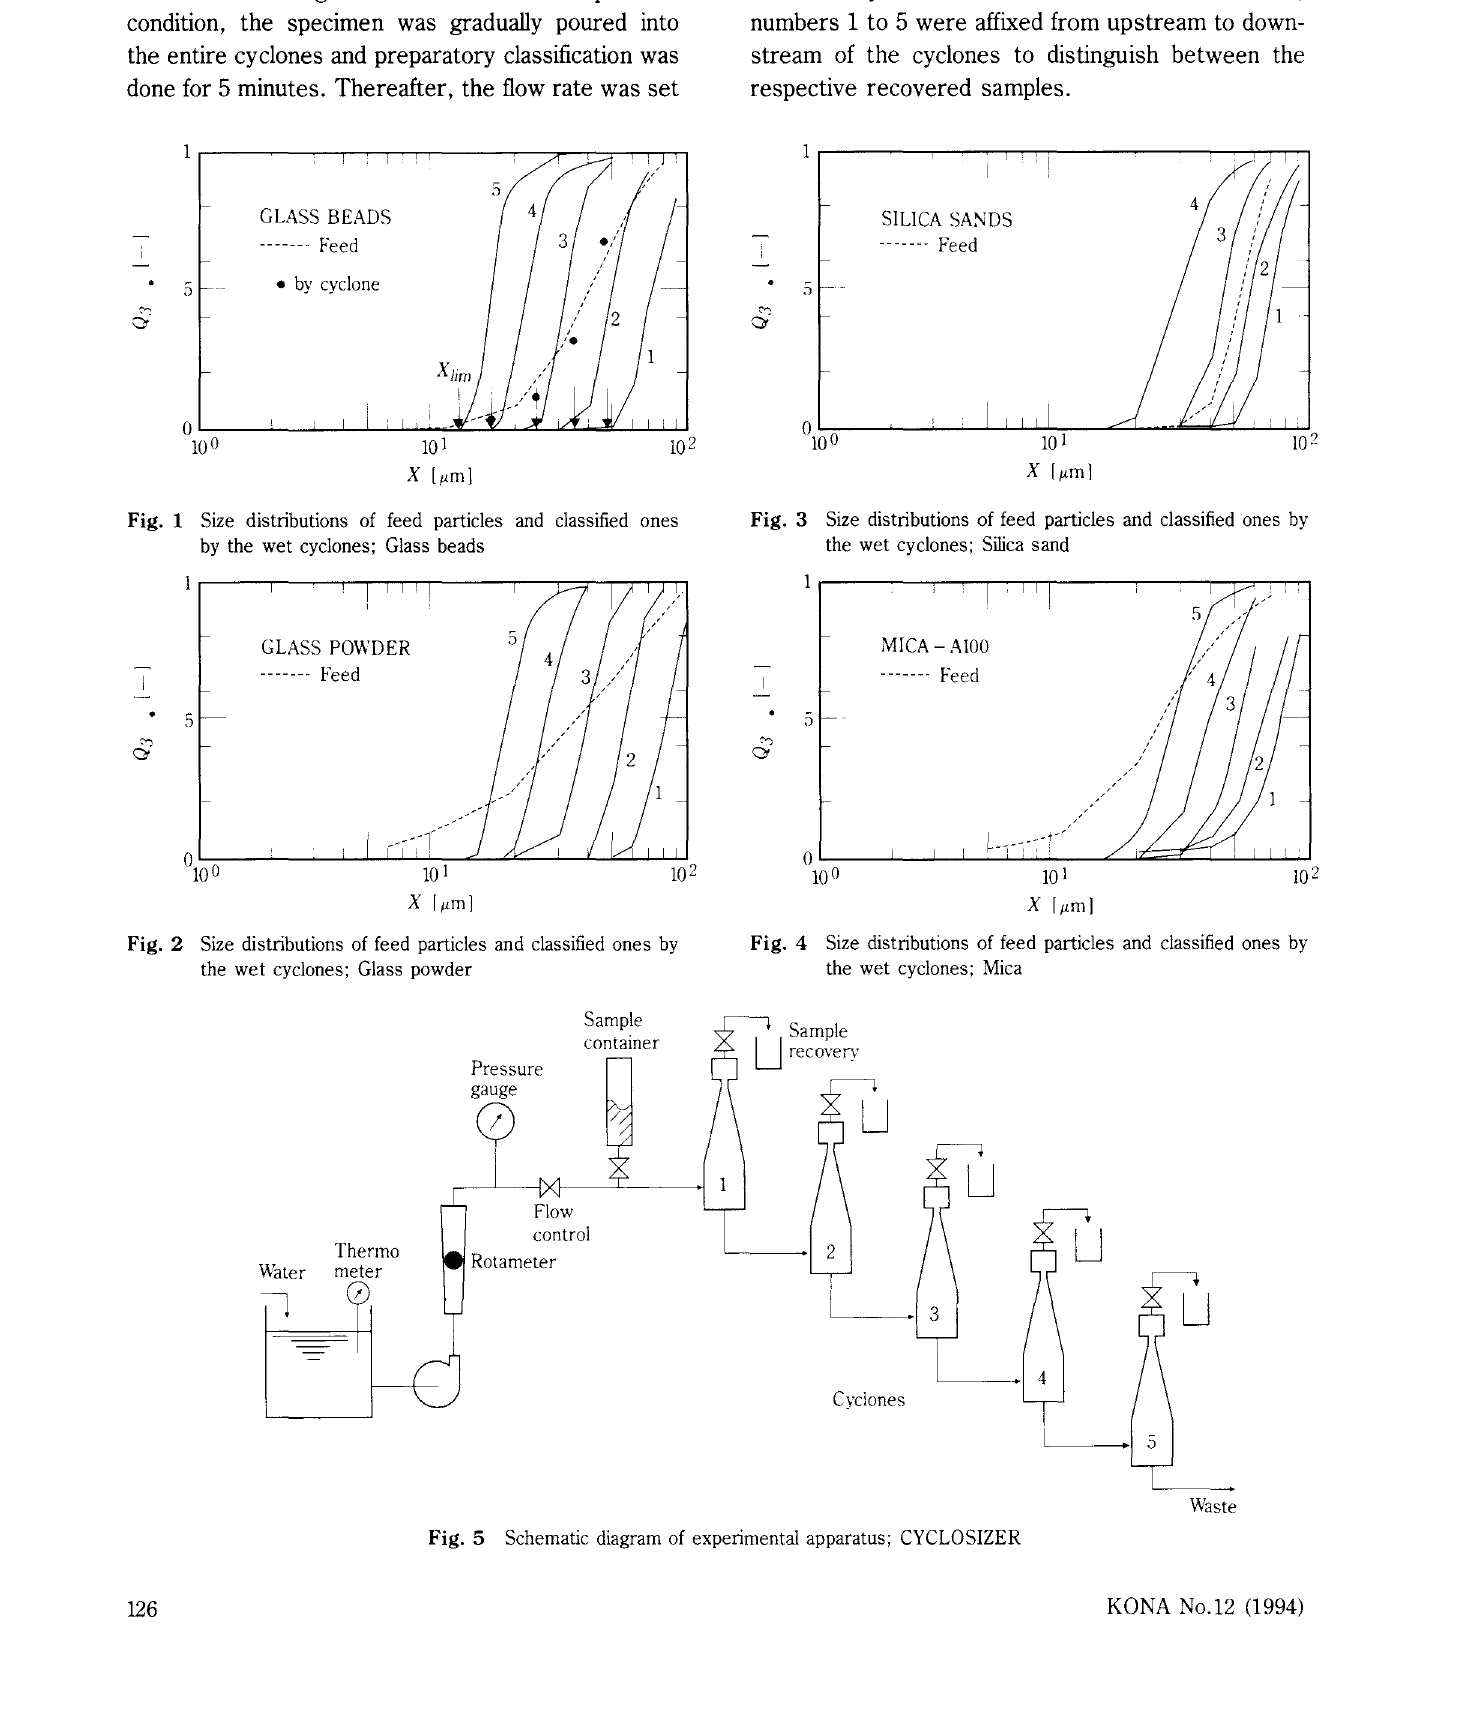
Fig. 3 Size distributions of feed particles and classified ones by